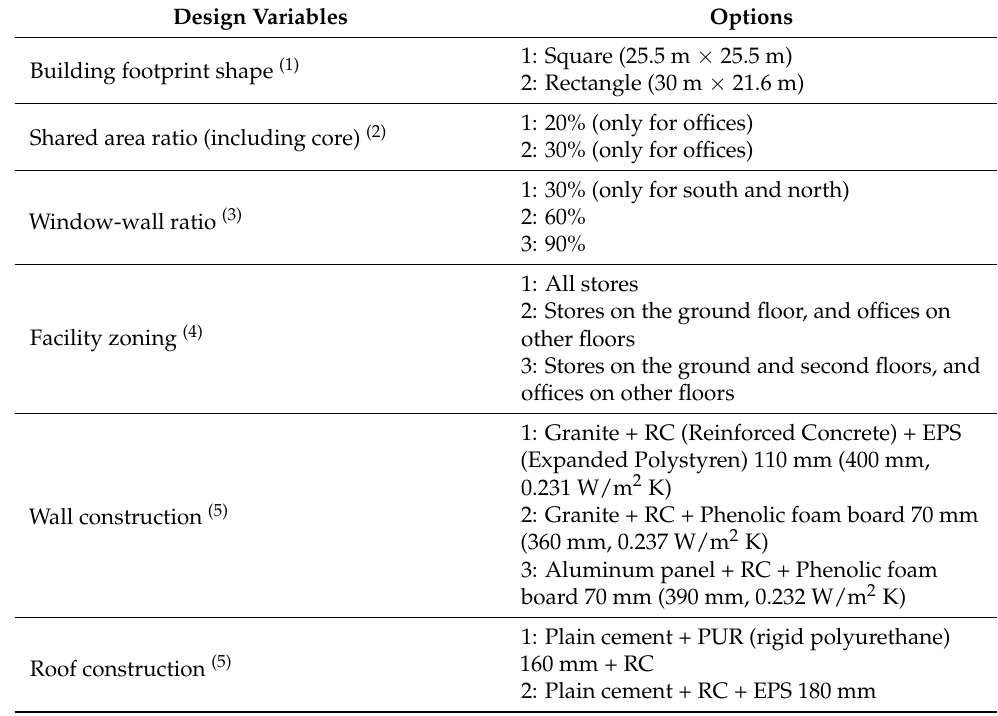
Table 5. Building and system specification